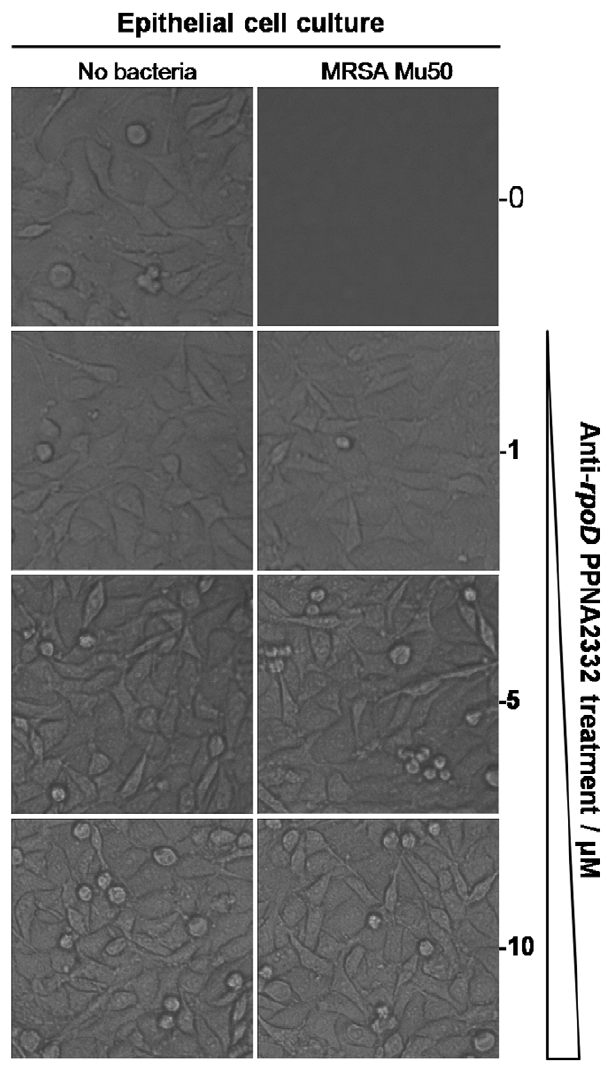
Figure 6. Light micrographs of epithelial cell cultures. The images show epithelial cell cultures grown in DMEM/HIGH Glucose, 10% FCS. The column at left shows epithelial cell cultures without added MRSA/VISA Mu50; the right column shows epithelial cell cultures that were inoculated with MRSA/VISA Mu50. The top panels of each column show cultures not treated with PPNA, and the rows below show cultures treated with increasing amounts of anti- rpoD PPNA2332 (1, 5, and 10 m M). Magnification, 6 100.